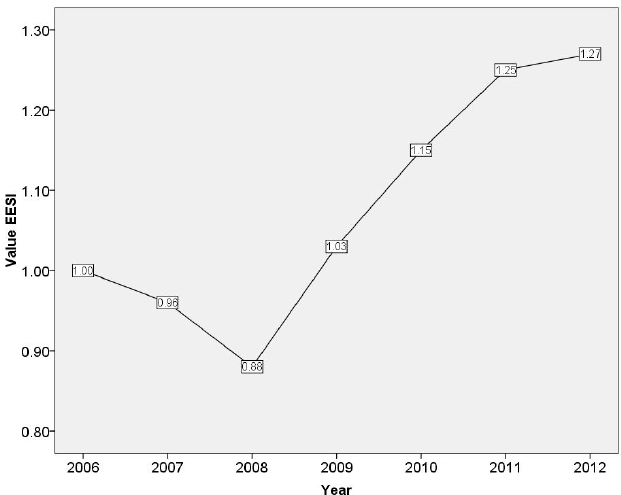
Figure 5. Variation curve of the emergy ‐ based ecological security index for Wuhan.